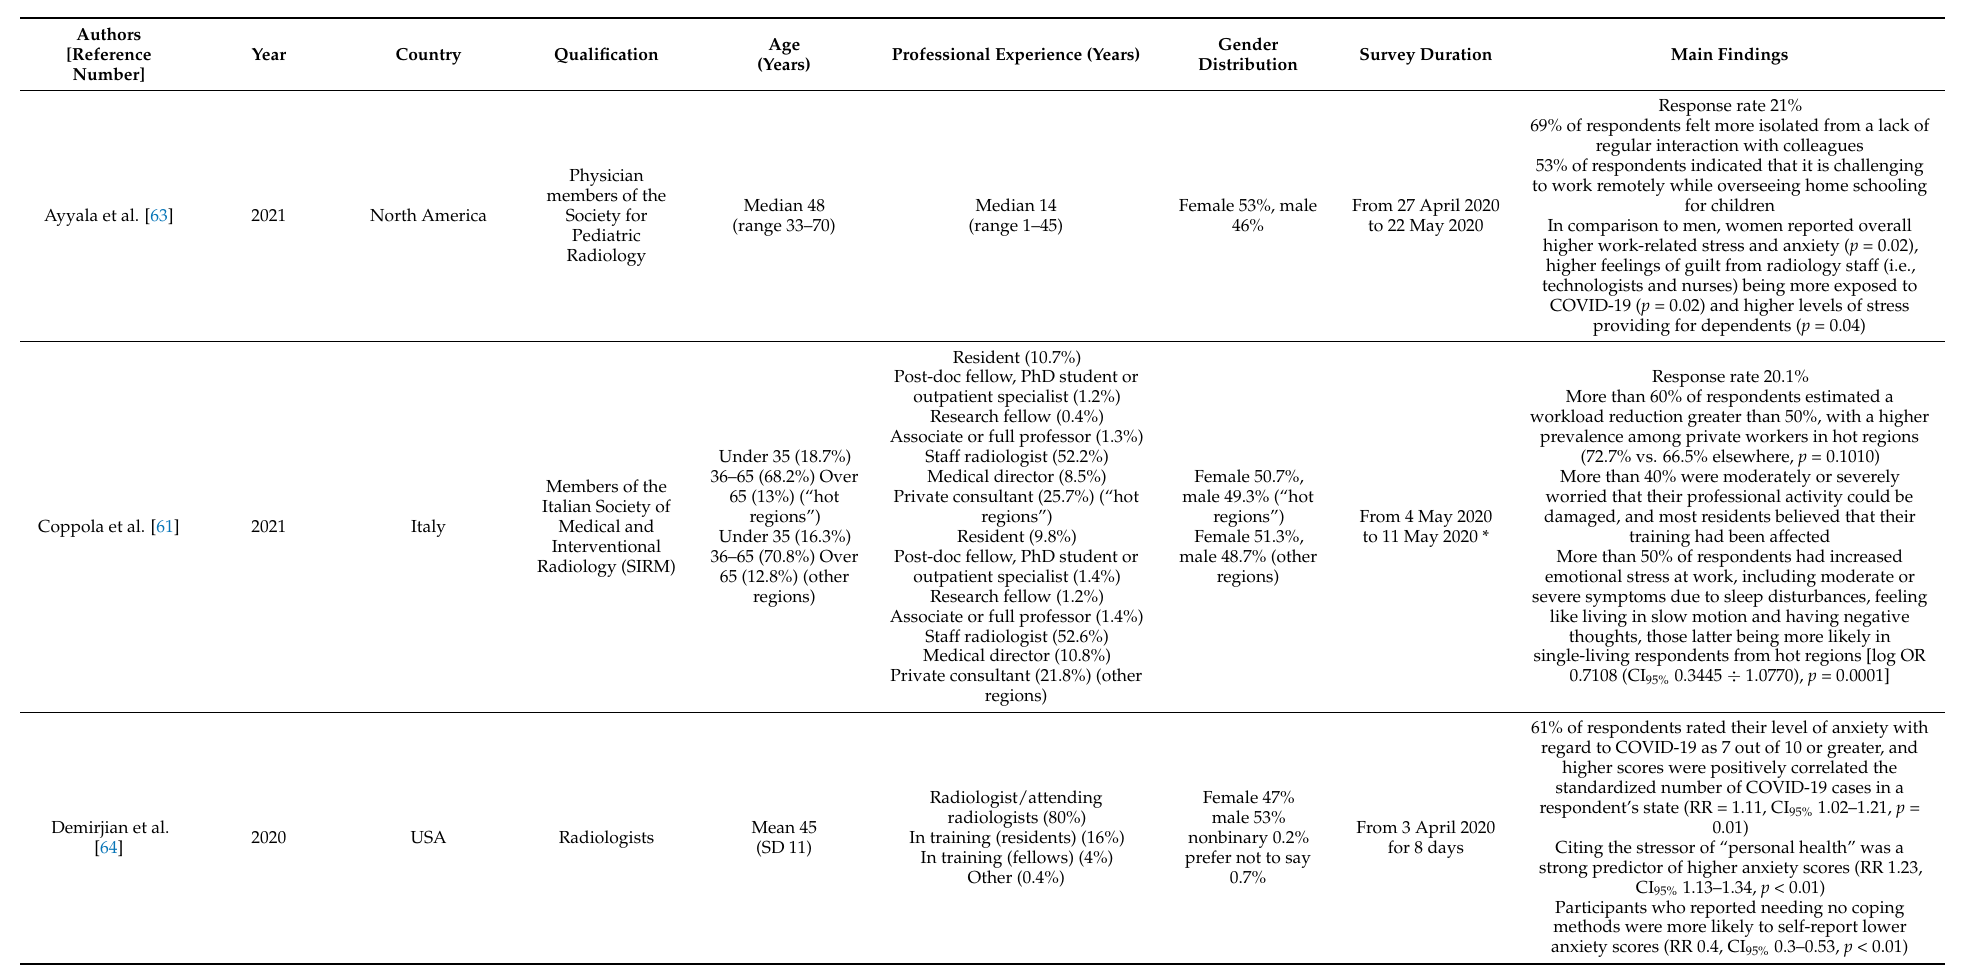
Table 1. Articles analyzed based on surveys. CI 95% = 95% confidence interval. OR = odds ratio. RR = relative risk. SD = standard deviation. * authors’ personal